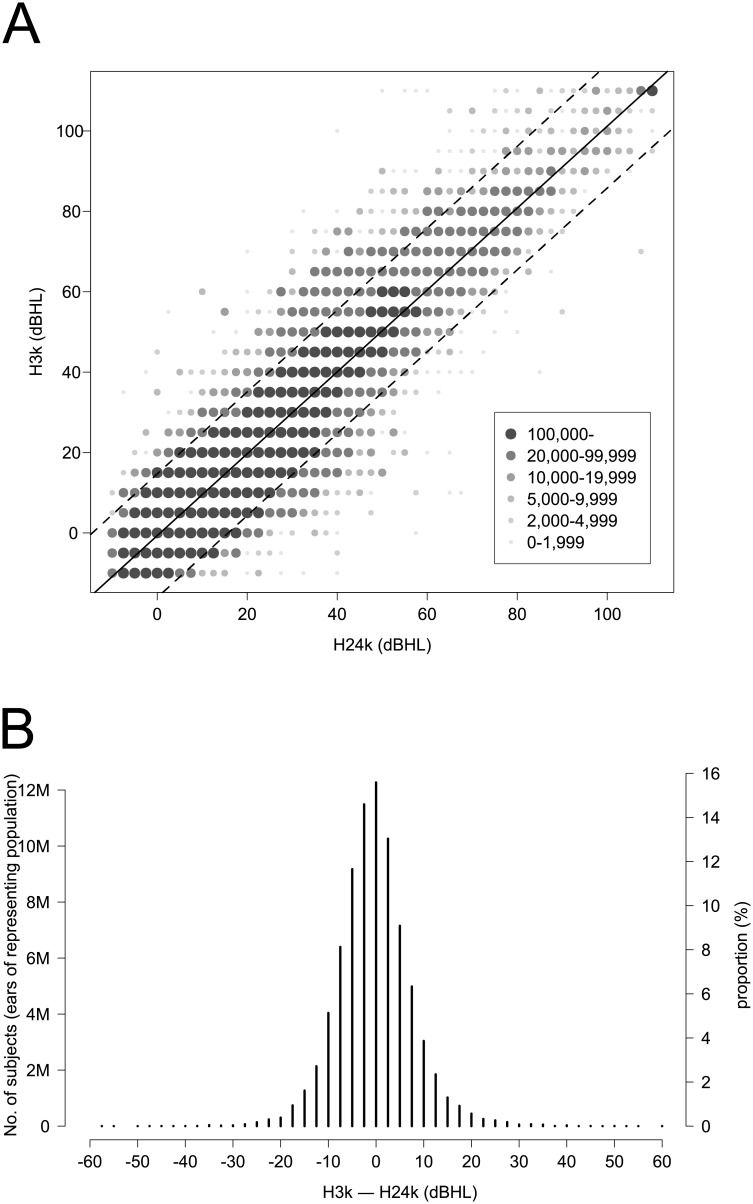
(A) Scatter plot between the threshold at 3 kHz (H3k) and the average of thresholds at 2 kHz and 4 kHz (H24k). (B) Distribution of the difference between H3k and H24k (weighted N = 39,357,497 × 2 ears).The scatter plot shows a statistically strong correlation between H3k and H24k (R = 0.92, p<0.0001). The predictive linear regression equation was y = –0.6821 + 1.0186x (x = H24k, y = H3k, p<0.0001, R2 = 0.849). The difference between the H3k and H24k displays a distribution pattern that is similar to a normal distribution. M: million; dBHL: decibel hearing level.